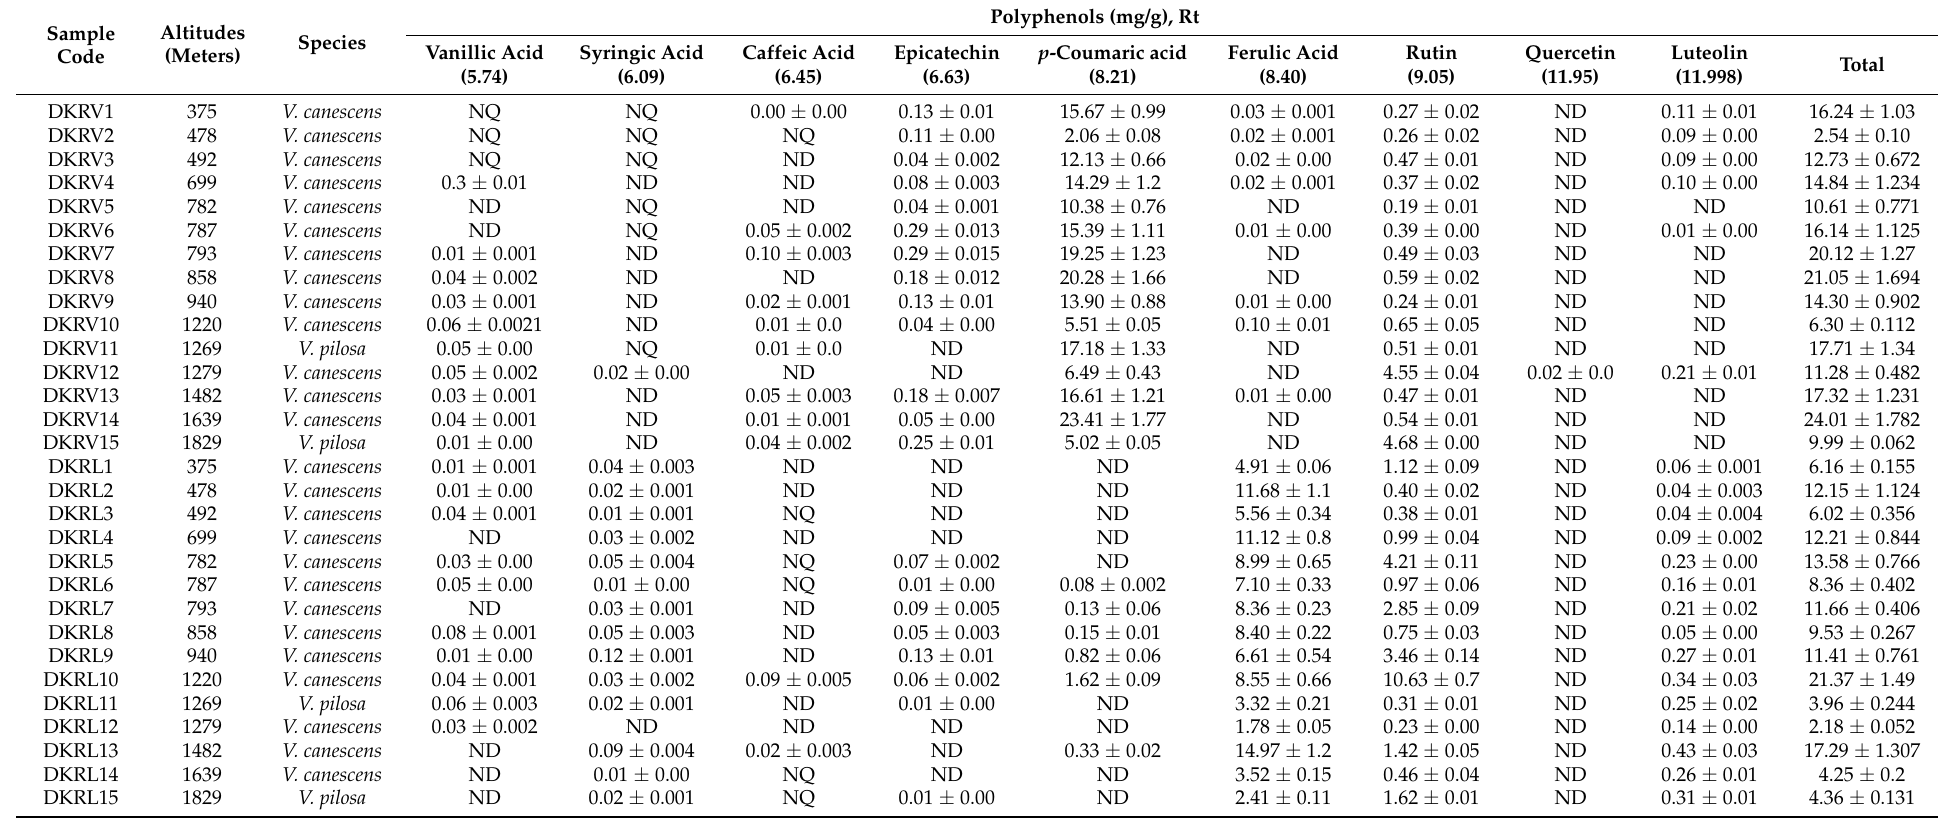
Table 2. Phenolic compounds present in different locations of Viola